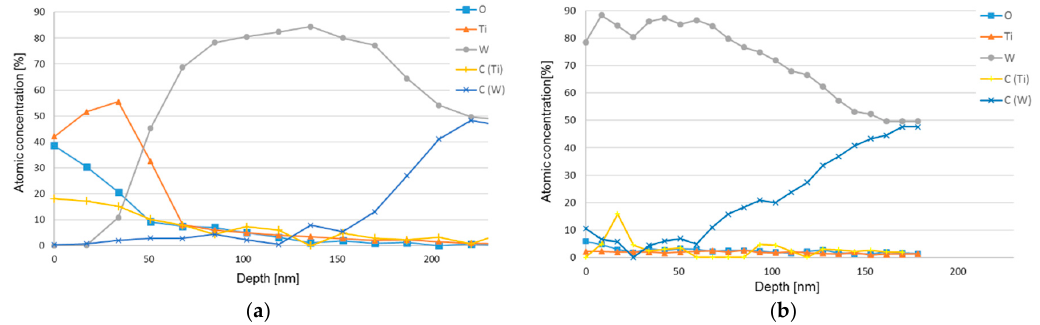
Figure 18. Auger electron spectroscopy (AES) depth profiles obtained from a region within the crater before ( a ) and after ( b ) the removal of the adhered work material layer by etching. The formation of a C-depleted WC zone, 100–150 nm in thickness, is clearly visible in both depth profiles. Also, note the possible formation of TiC in the adhered work material layer in a).